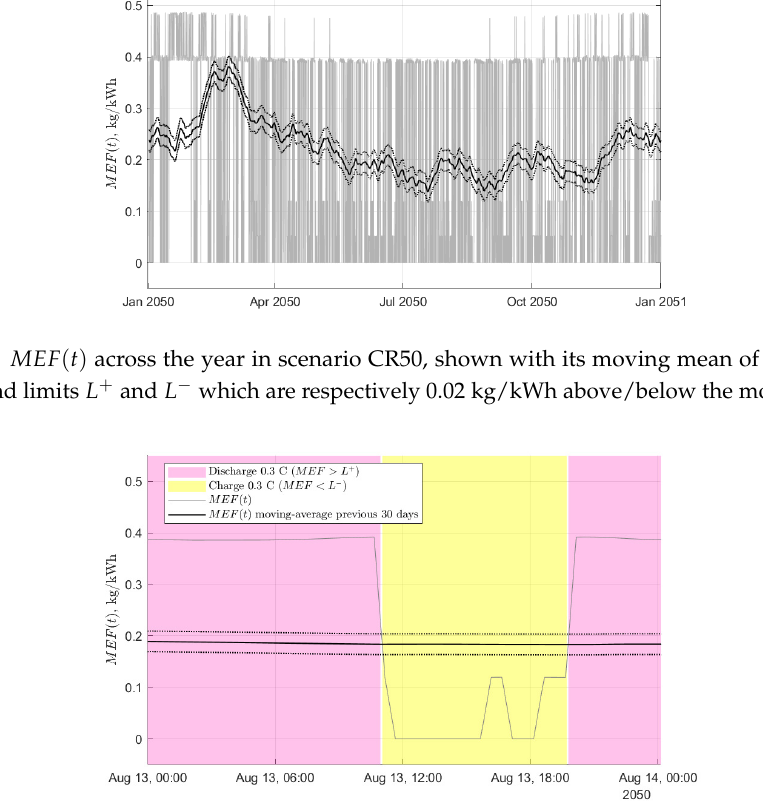
Figure A2. The above figure zoomed in to 13 August, showing charge and discharge modes of the battery, defined respectively as when MEF ( t ) < L − and MEF ( t ) > L +